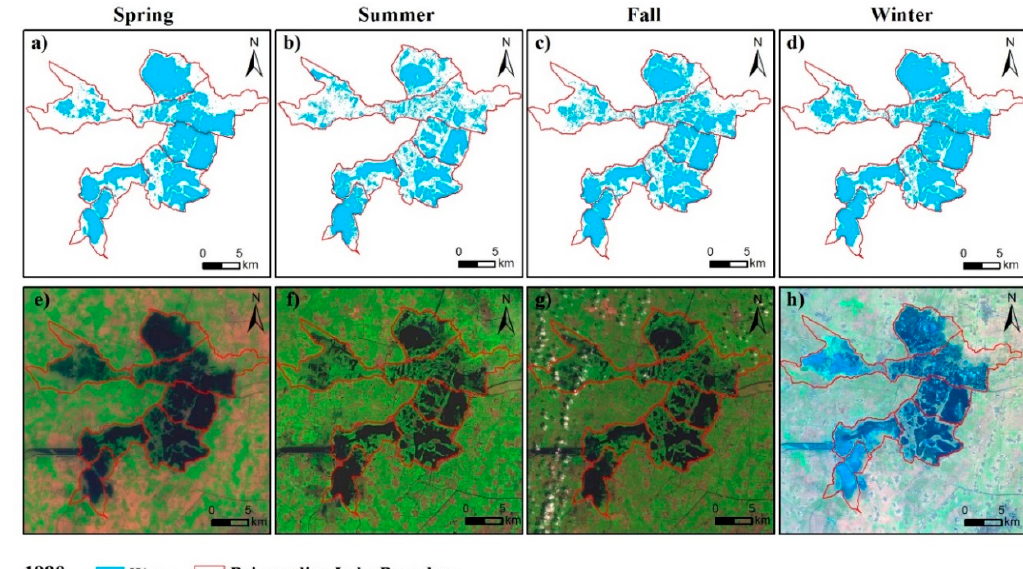
Figure 6. Comparison of water extraction results and original images for all four seasons in 1990. Extracted water surface in the ( a ) spring, ( b ) summer, ( c ) fall, and ( d ) winter of 1990. False color images (bands: 6, 4, and 2) of ( e ) spring, ( f ) summer, ( g ) fall, and ( h ) winter in 1990.